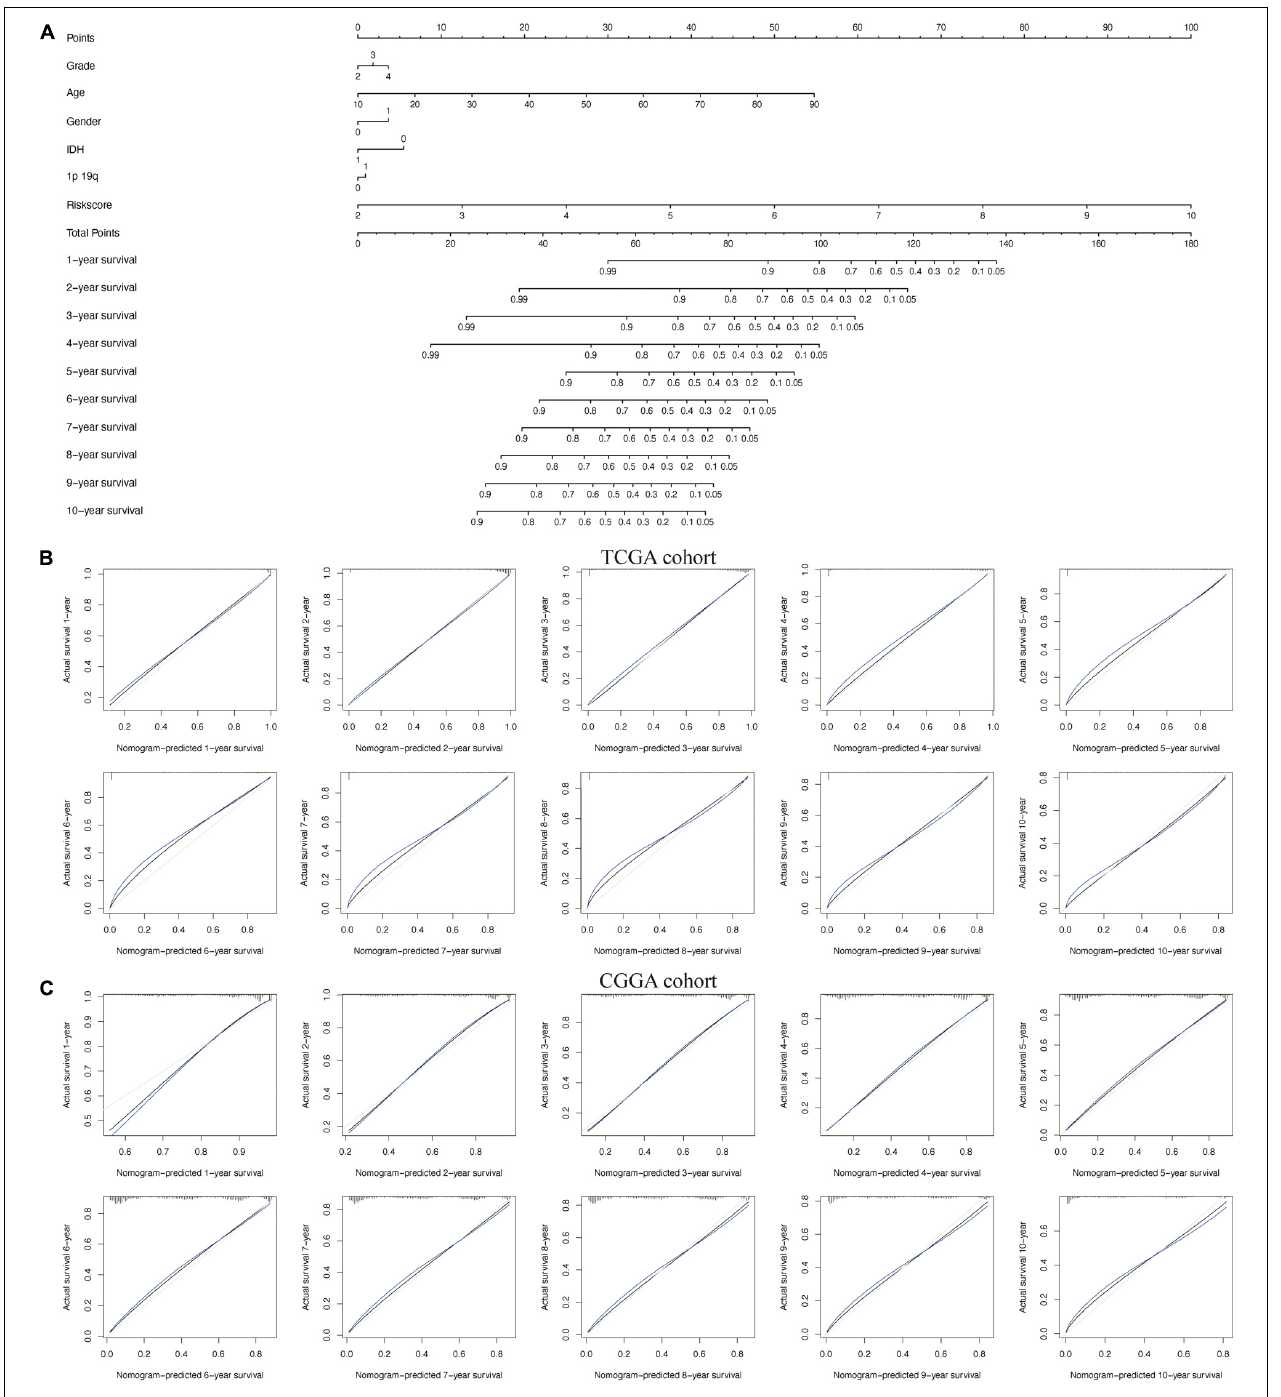
FIGURE 7 | Nomogram for predicting overall survival of patients with glioma. (A) A nomogram integrating the signature risk score with the pathologic characteristics. (B,C) The calibration curve for the nomogram in The Cancer Genome Atlas (TCGA) and Chinese Glioma Genome Atlas (CGGA) cohorts.